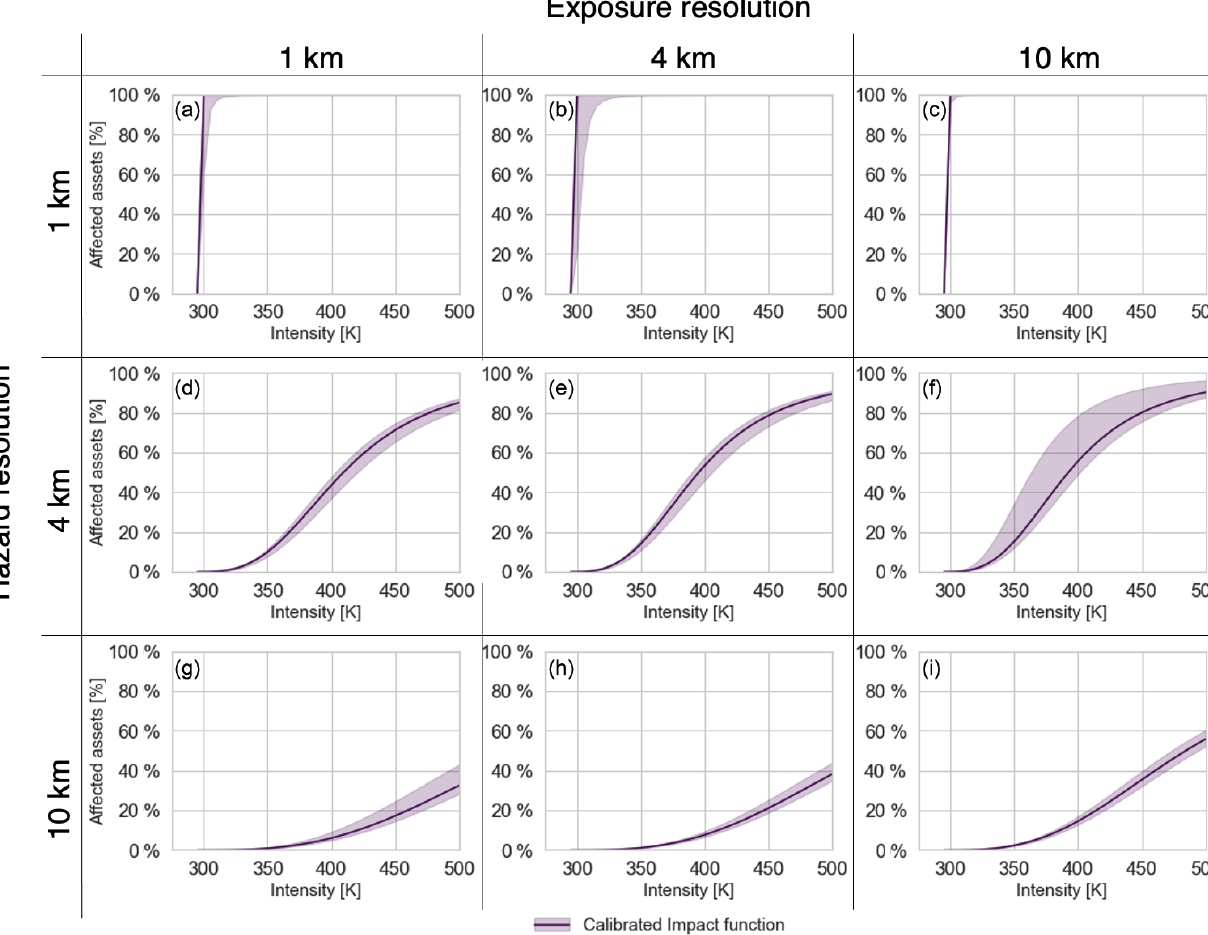
Figure A1. Calibrated impact functions for different resolutions of hazard and exposure. The curves relate satellite-detected fire temperature to a damage percentage at that location. The shading indicates uncertainties as assessed using a 10-fold cross-validation of model parameter I half (see Sect. 2.2.2). The shape of the impact functions remain relatively stable across different exposure resolutions and becomes steeper with increasing hazard